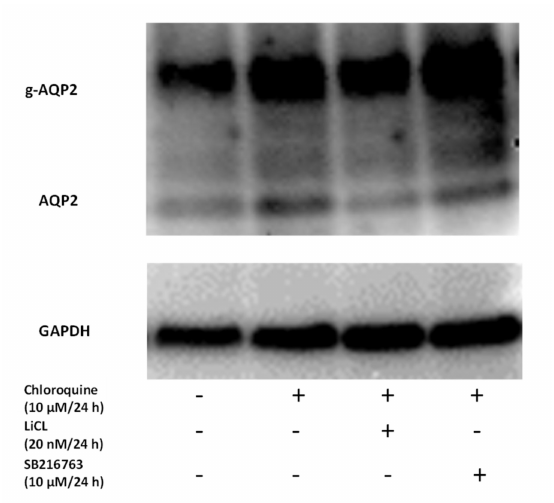
Figure 10. Treatment with chloroquine had a similar e ff ect to bafilomycin. The expression of Aqp2 in IMCD cells treated with chloroquine alone (10 µ M / 24 h) or in combination with LiCl (20 mM / 24 h, or the GSK3 α / β inhibitor SB216763 (10 µ M / 24 h) was analyzed by Western blot. Afterwards, the antibodies were stripped, and the membrane was incubated with GAPDH (n = 1).